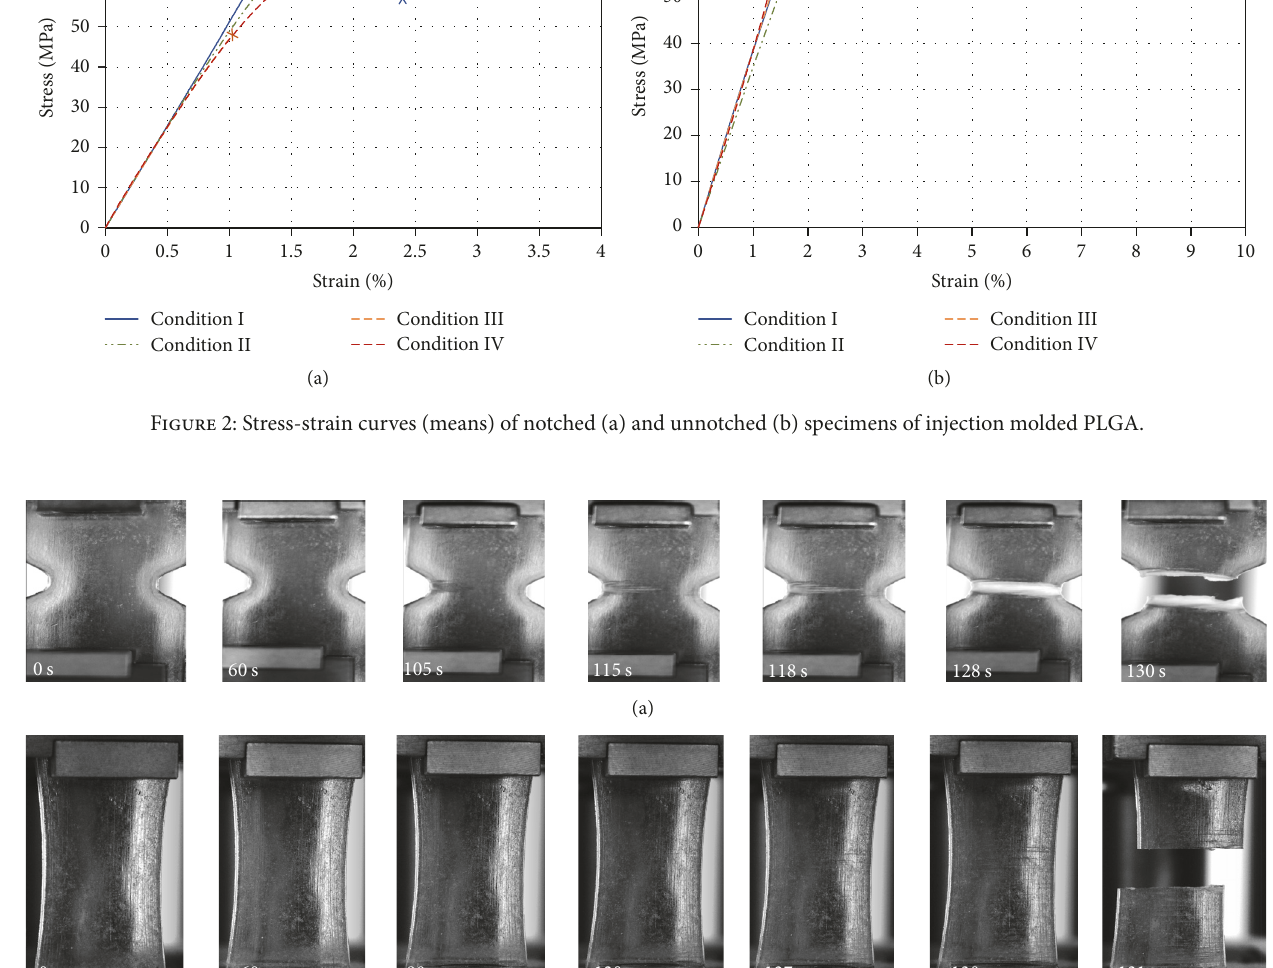
unnotched groups of specimens. However, there was a high standard deviation found for 𝜎 𝑢 in the notched group injected under Condition III (see Table